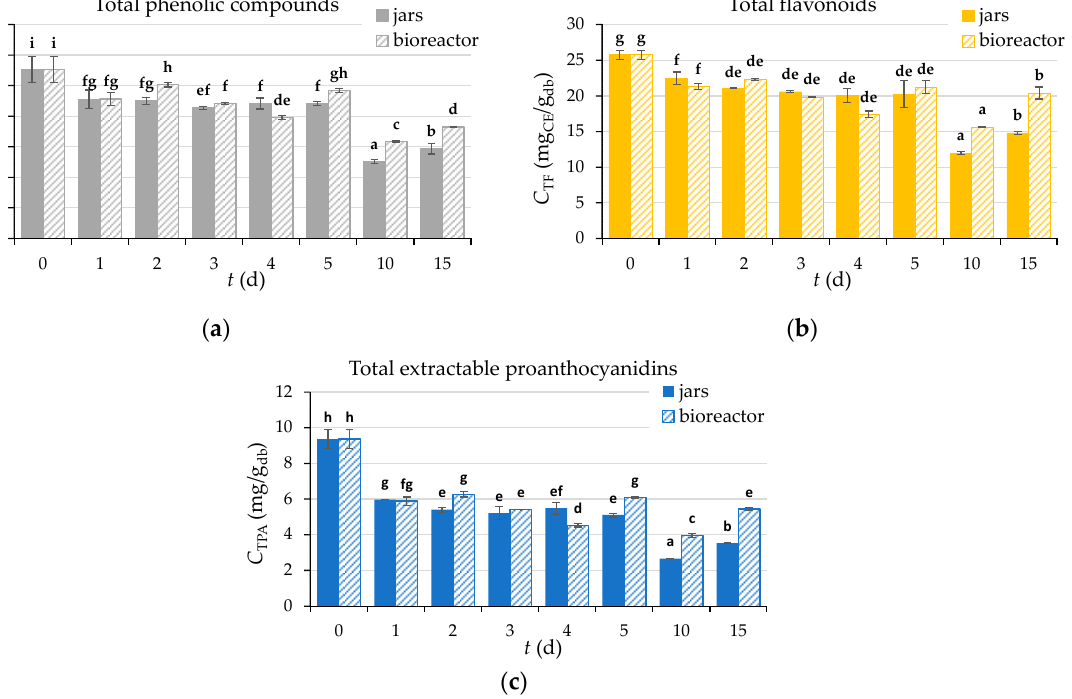
Figure 5. The content ( C ) of total phenolic compounds, TPC ( a ), total flavonoids, TF ( b ) and total extractable proanthocyanidins, TPA ( c ) in extracts obtained from GP before (day “0”) and after SSF with R. oryzae in laboratory jars and tray bioreactor (days 1–5, 10, 15). Samples marked with different lowercase letters of the alphabet are statistically significantly different from each other ( p < 0.05, post-hoc Duncan’s multiple range test).